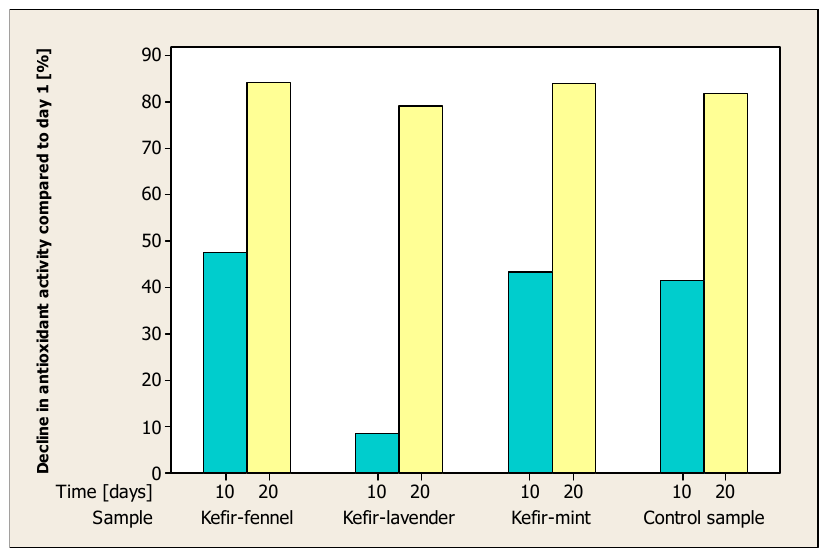
Figure 6. The decline in antioxidant activity on day 10 and day 20 of storage compared to day 1 of storage for kefir samples.